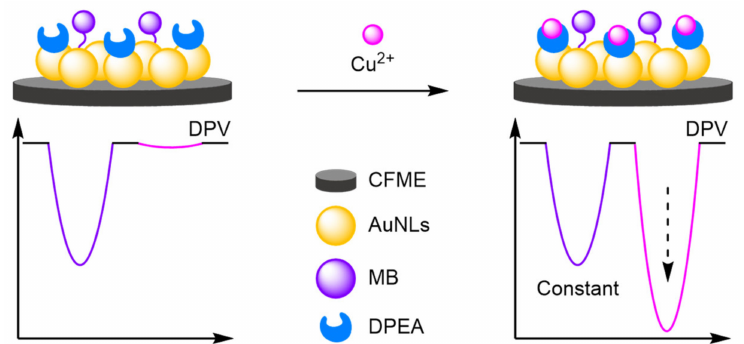
Figure 34. Schematic representation of a carbon fibre microelectrode for in vivo detection of Cu 2+ and